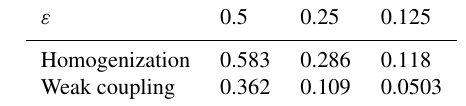
Figure 3. Left: comparison of the ensemble spread for the origi- nal oscillating triad system of Eq. (21) for ε = 0 . 25 from an initial condition ( − 1,0,0) (the ensemble mean is the blue dashed line, 2 σ interval the blue shaded area), the two-level Ornstein–Uhlenbeck process from the weak coupling method of Eq. (27) from an ini- tial condition ( − 1,0) (ensemble mean: red dashed line, 2 σ inter- val: red dotted lines) and the one-level Ornstein–Uhlenbeck process from homogenization (Eq. 22) from x = − 5 (ensemble mean: green solid line, 2 σ interval: dotted lines) B ( 0 ) = − 0 . 75, B ( 1 ) = − 0 . 25, √ √ B ( 2 ) = 1, ω = 1 / 12, γ 1 = 1 /δ , σ 1 = 2 /δ , γ 2 = 1 and σ 2 = 2 with δ = 0 . 75. The ensemble size is 4000. Right: cumulative his- tograms of exit times from [− 1 , 1 ] for the rapidly oscillating triad (Eq. 21) with ε = 0 . 5, the homogenized equation (Eq. 22) and the two-level Ornstein–Uhlenbeck process from the weak coupling method (Eq. 27), calculated from 1000 independent trials. Table 3. The relative error on the mean exit time E | E | / E − E 1 (τ) 0 (τ) 0 (τ) where 0 (τ) is the mean exit time from [− 1 , 1 ] of the full triad system of Eq. (21) and E 1 (τ) is the mean exit time of the parameterized systems of Eqs. (22) and (27). The parameters are the same as those used for Fig. 3. These values are calculated from 1000 independent trials.